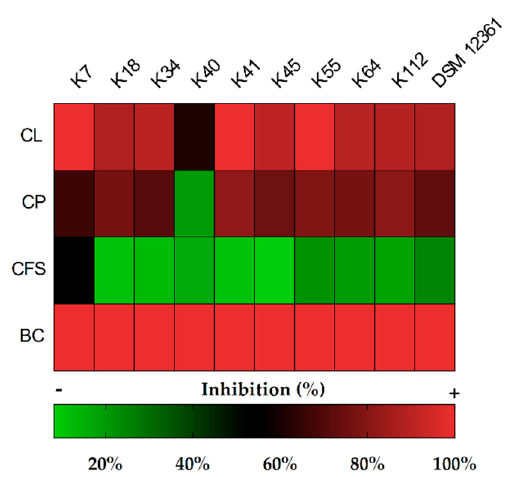
Figure 1. Heatmap of inhibition (%) against Ascosphaera apis DSM 3116 (radial growth) on Malt Extract Agar (MEA) plates after 6 days, using culture broth (CB), cell pellets (CPs), cell-free supernatants (CFSs), and cell lysates (CLs) of the Lactobacillus kunkeei strains.